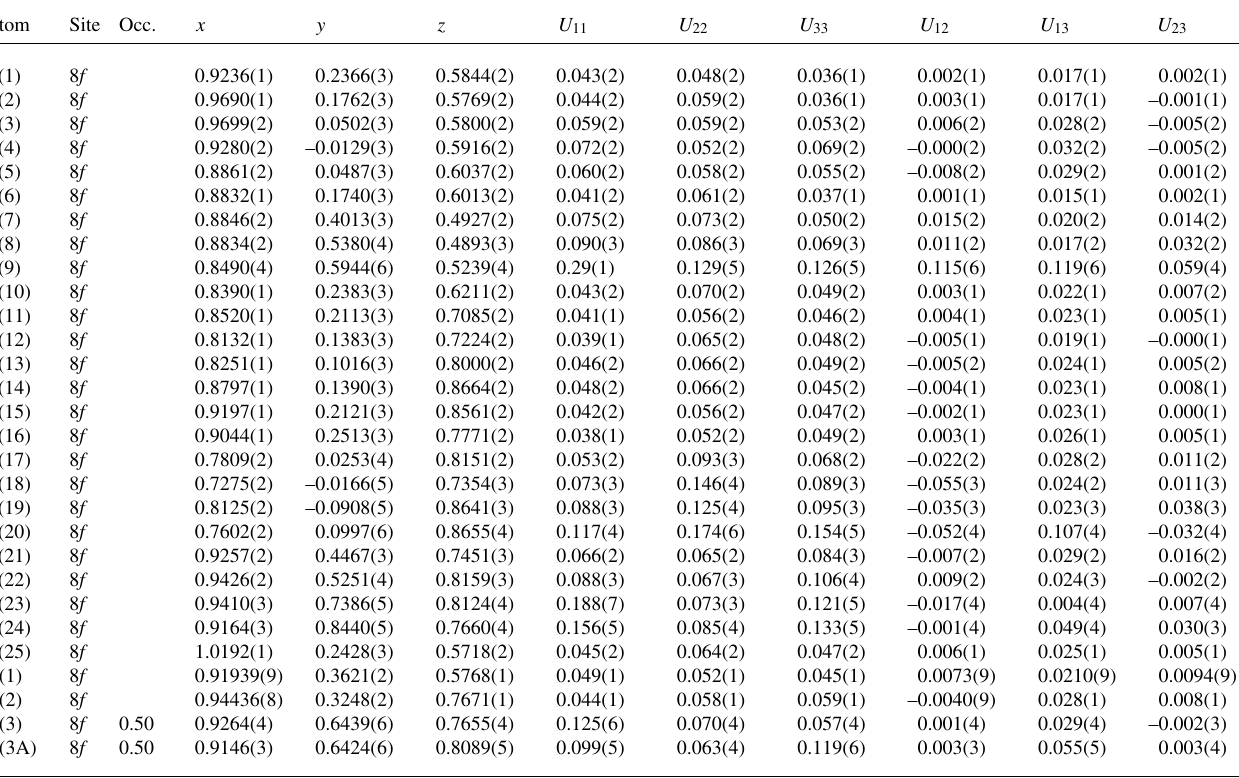
Table 3. Atomic coordinates and displacement parameters (in Å 2 ) .